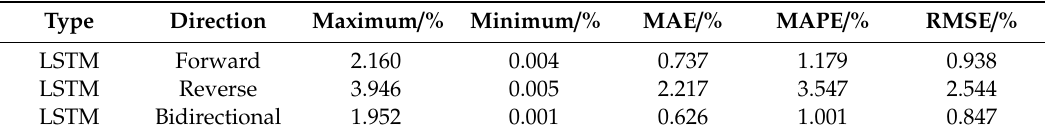
Table 8. Comparison of error statistical results.